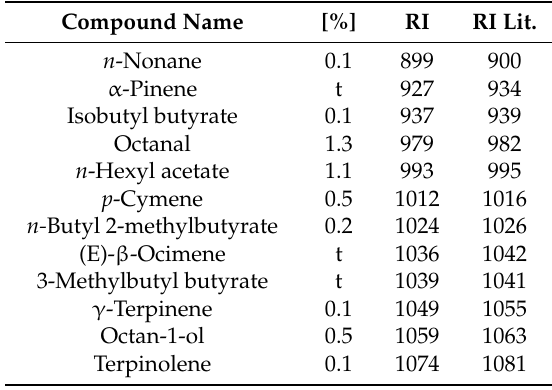
Table 1. Content of components in Heracleum mantegazzianum essential